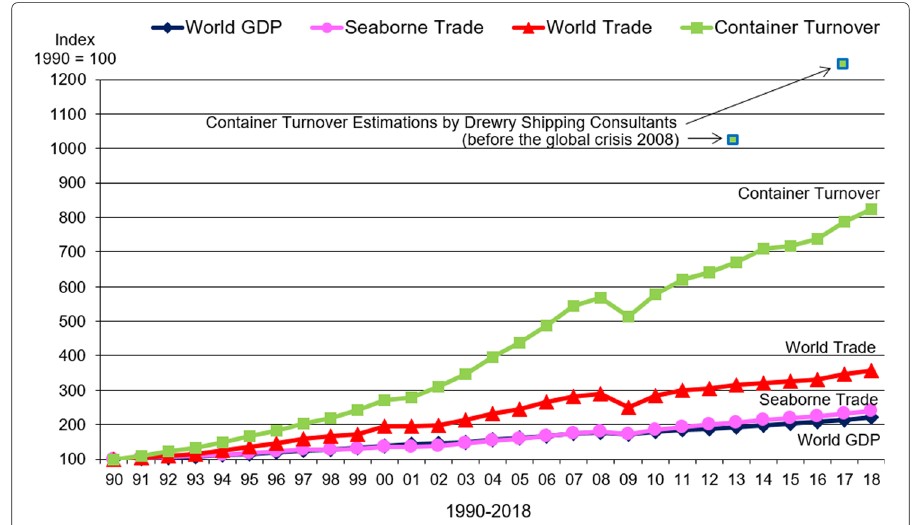
Fig. 1 Container turnover, world trade, seaborne trade, and world GDP 1990–2018 with a forecast by Drewry Shipping Consultants for the container turnover for 2012 to 2016 before the global crisis 2008/2009; Data sources: United Nations Conference on Trade and Development (UNCTAD)–Secretariat (2019) and previous